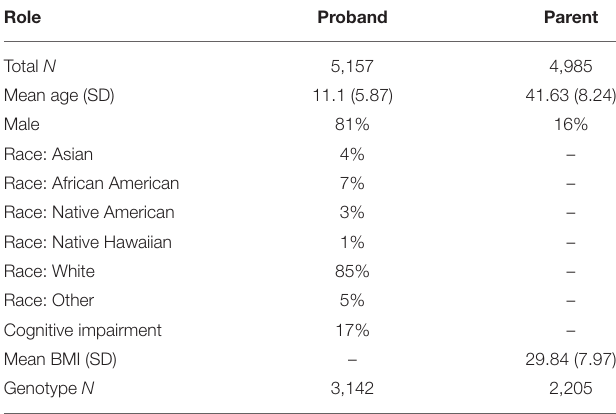
TABLE 3 | Demographic summary of the